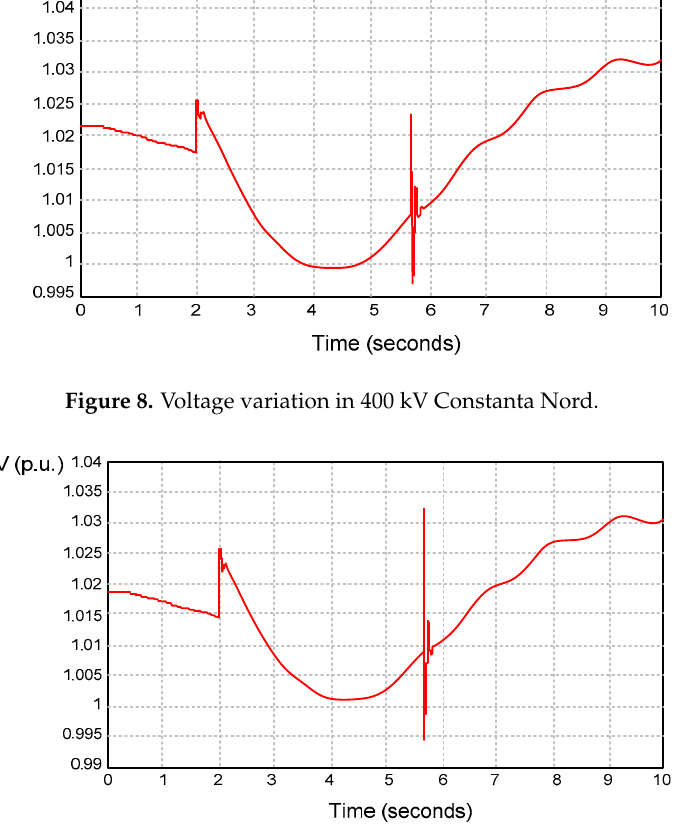
Figure 9. Voltage variation in 400 kV Tariverde.